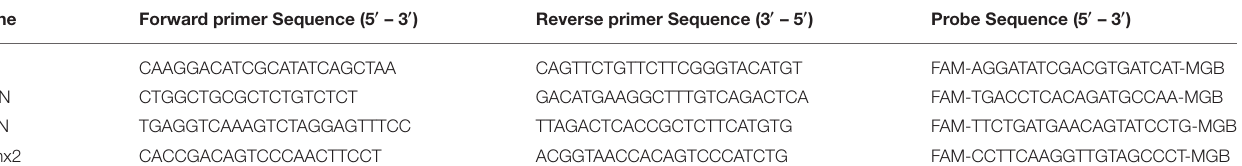
TABLE 1 | Table of primers. Gene Forward primer Sequence (5 ′ – 3 ′ )